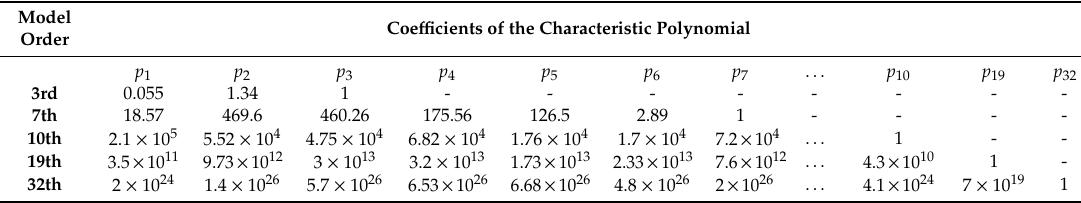
Table 4. Characteristic polynomial coe ffi cients with di ff erent order LTI models. Plant 4 and a = − 0.001 Model Coe ffi cients of the Characteristic Order